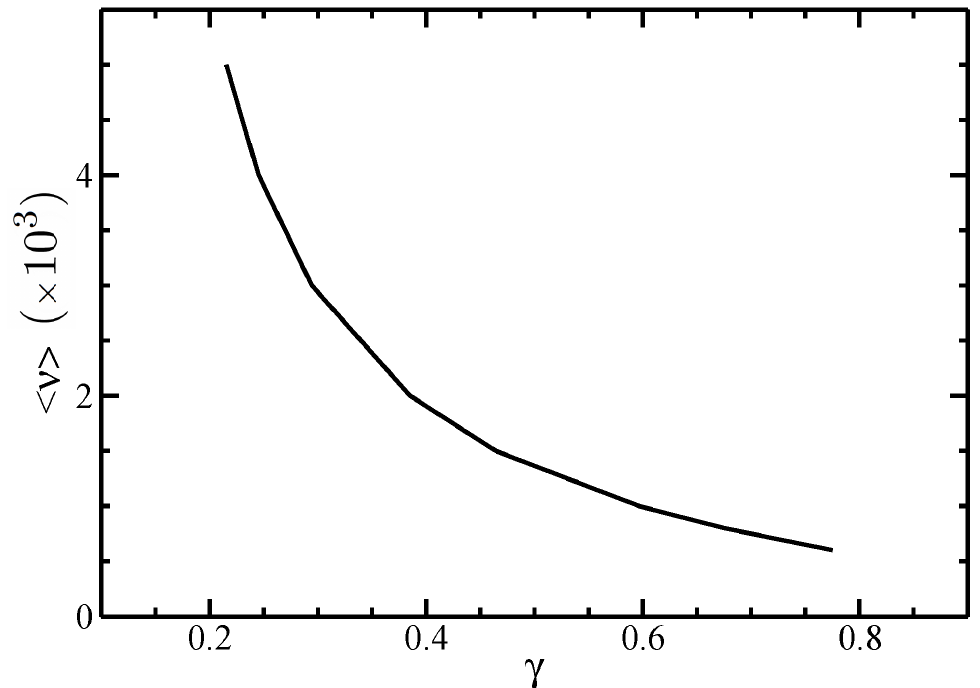
Figure 3. The parameter γ as a function of the average size < ν > at the I–N phase equilibrium. The normalized standard deviation is σ =